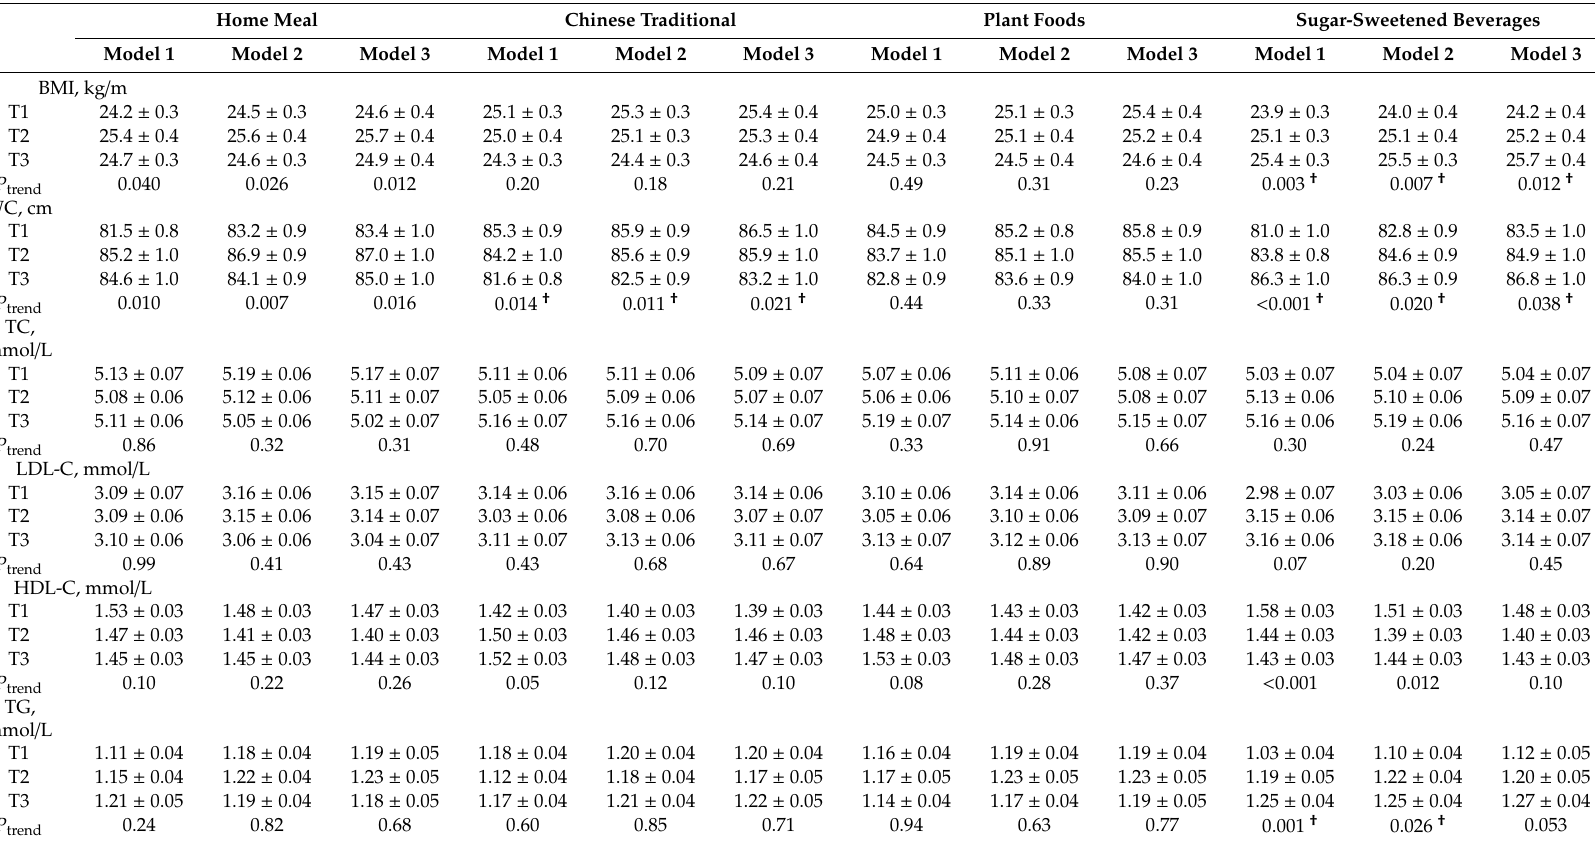
Table 4. Cardiometabolic risk markers of subjects across tertiles (T) of dietary patterns ( n =